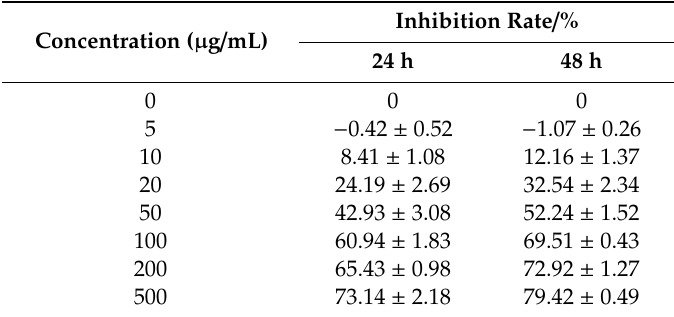
Table 2. Inhibition rate of Free PR on B16 cell proliferation (n = 6, x ±